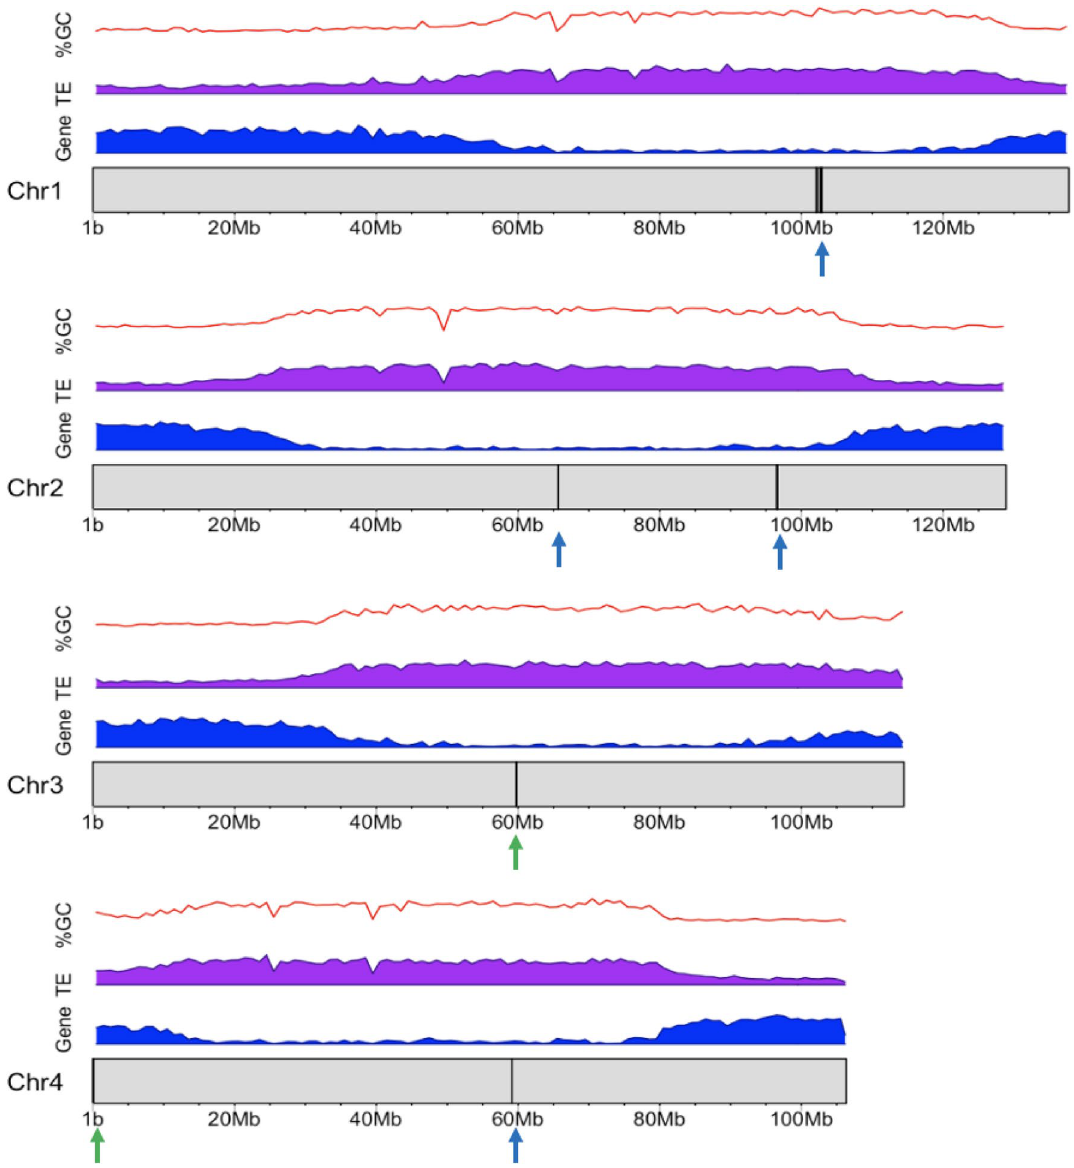
Figure 2. Gene density (blue), TE (Class I and II) density (purple), % GC (red), distribution of 5S (blue arrows) and 45S (green arrows) rRNA in the P. ovata genome. The figure was generated in R using the karyoploteR library 19 . The x-axis represents genome position (Mb) and the y-axis represents gene density using a sliding window of one megabase in